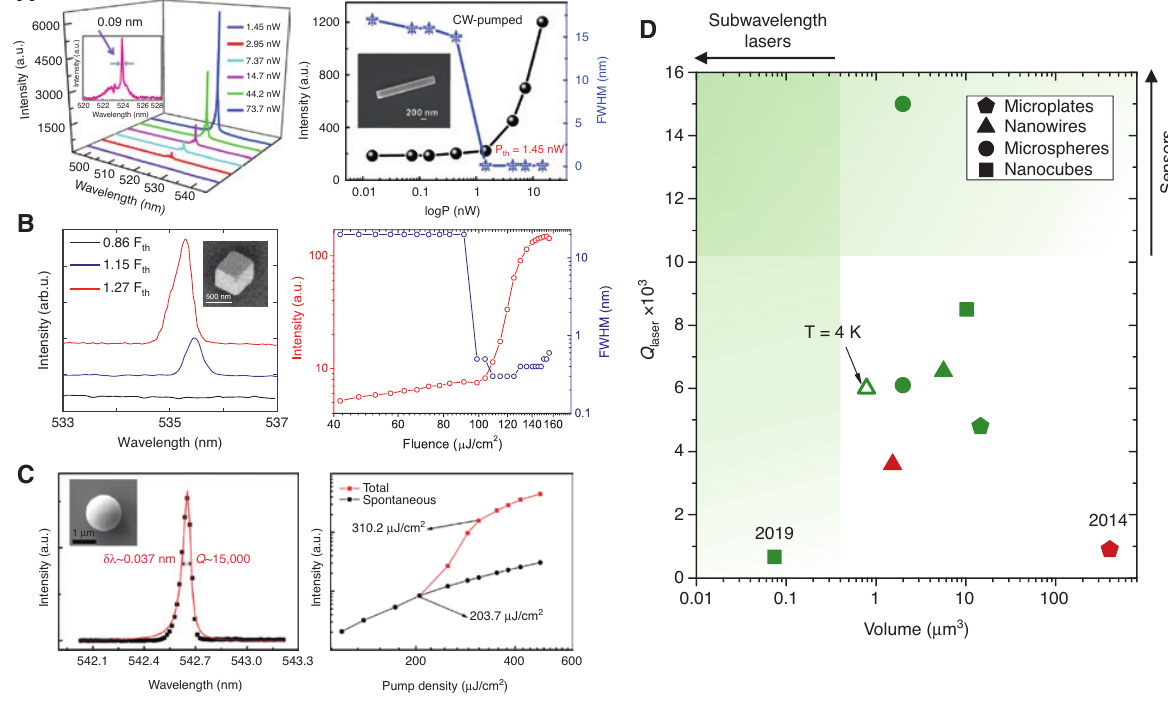
Figure 4: Experimental demonstration of single-particle lasers. (A) The fluence dependence of continuous wave (CW) pumped lasing spectra from a single CsPbBr fluence dependence of CW pumped lasing intensity (blue) and full width on half maximum (FWHM) (black) from a single CsPbBr indicating a low threshold of 1.45 nW and high Q factor around 6000. (B) Pump intensity-dependent emission spectra at different values of fluence below and above the lasing threshold (left) for 480-nm nanocube laser and output emission intensity (red) and emission FWHM (blue) as a function of pump fluence (right). (C) Integrated emission intensity as a function of pump fluence showing the lasing threshold around 200 μ J/cm 2 (left) and Lorentz fitting of a lasing oscillation mode at 542.6 nm (right), giving an ultrasmall line width of 0.037 nm, corresponding to an ultrahigh Q factor around 15,000. (D) Experimental values of lasing mode quality factors for different perovskite lasers of different shapes (microplates [8, 94], nanowires [15, 89, 104], microspheres [16, 78], and nanocube [17, 33]) vs. volume. The colors of sign show the color of laser: green: 500–550 nm, red: 690–780